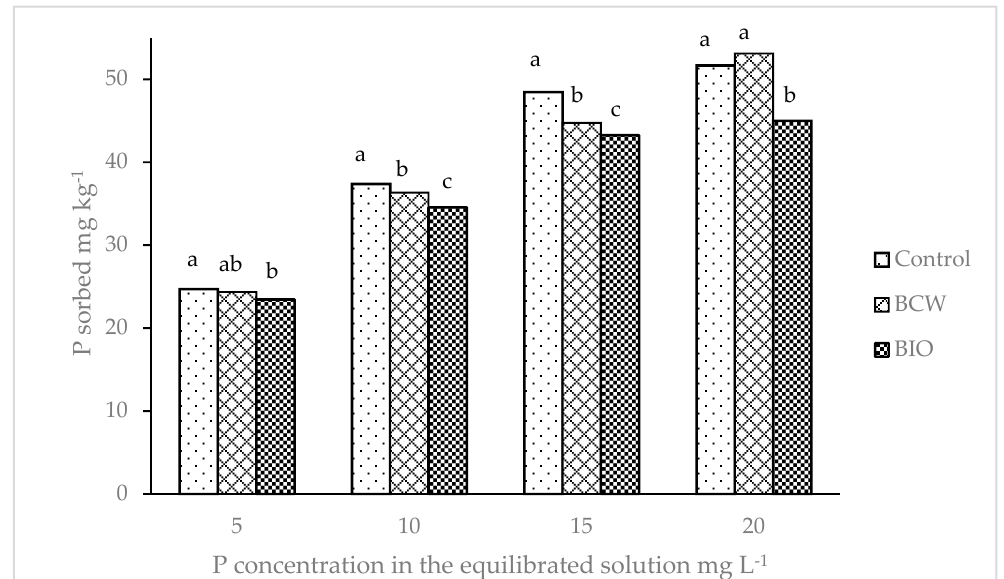
Figure 2. Phosphorus sorption of soil amended with brown coal waste (BCW), biochar (BIO) and untreated soil (Control). a, b, c letters indicate significant differences ( p < 0.05) between treatment means, separately for each equilibrium solution.